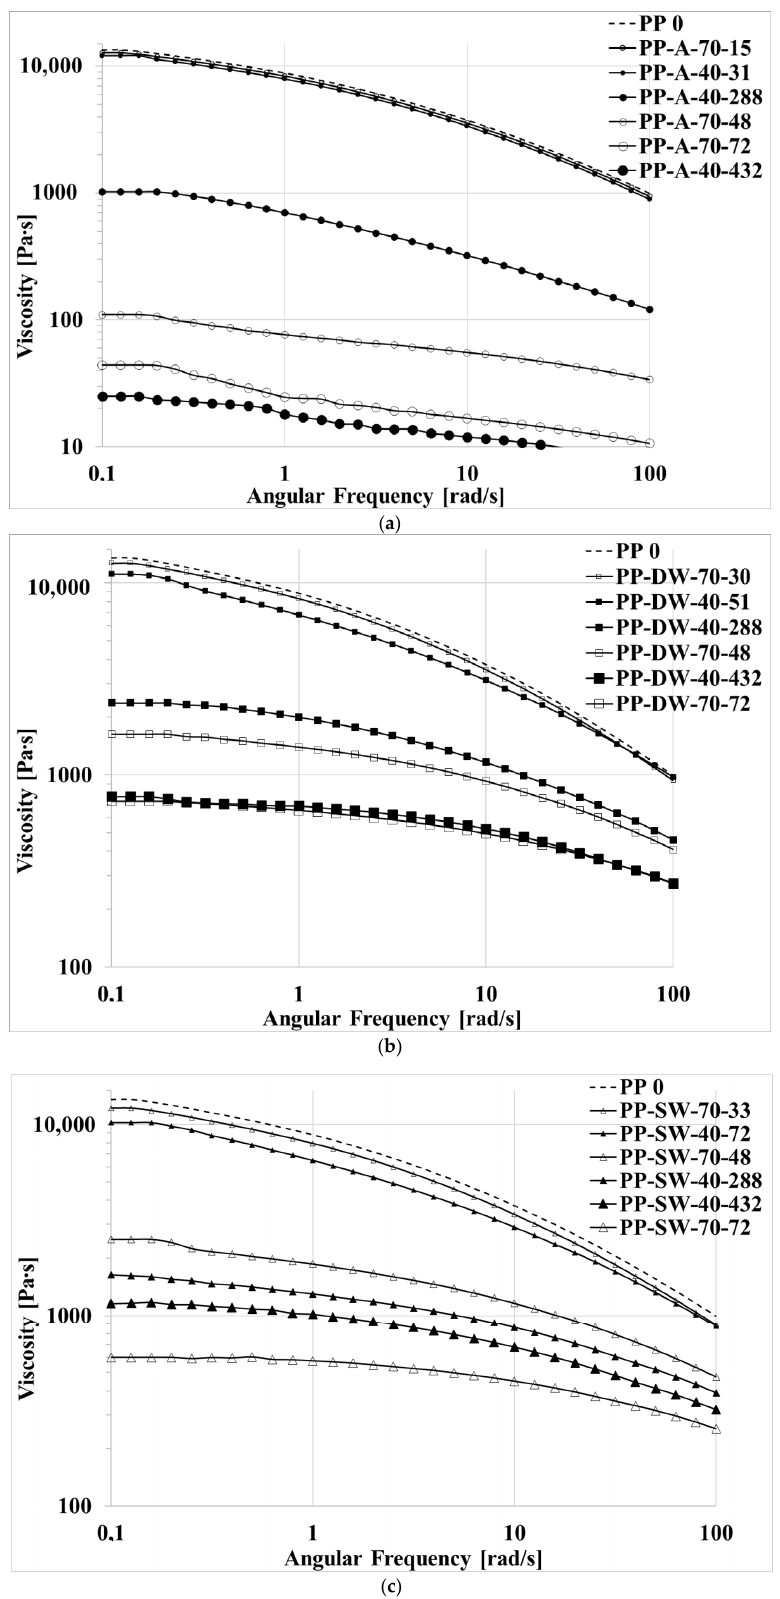
Figure 2. Flow curves of virgin PP and of photo-oxidized samples in ( a ) air, ( b ) distilled water and (c) sea water. The viscosity of all the samples decreases with increasing irradiation times. Because the viscosity is strongly dependent on the molecular weight, this means that the PP sample undergoes a relevant degradation process. The decrease is much more pronounced when the temperature increases and when the photo-oxidation occurs in air. As for the samples photo-oxidized in the two water samples, the viscosity decreases slightly more in the distilled water. In Figure 3, the dimensionless molecular weight is reported for all the samples. The dimensionless molecular weight was calculated with the equation η 0 = kMw^ 3.4